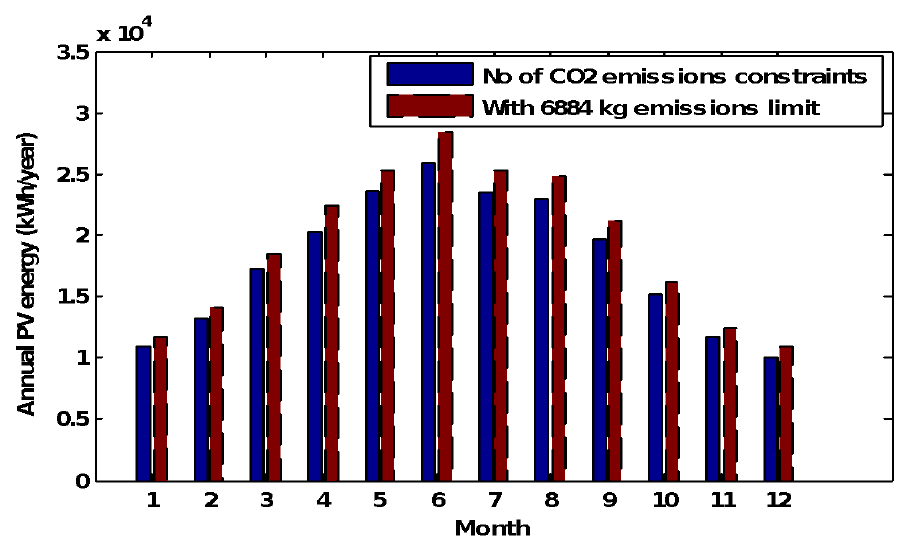
Figure 6. Monthly PV energy in a year with and without constraints using PSO